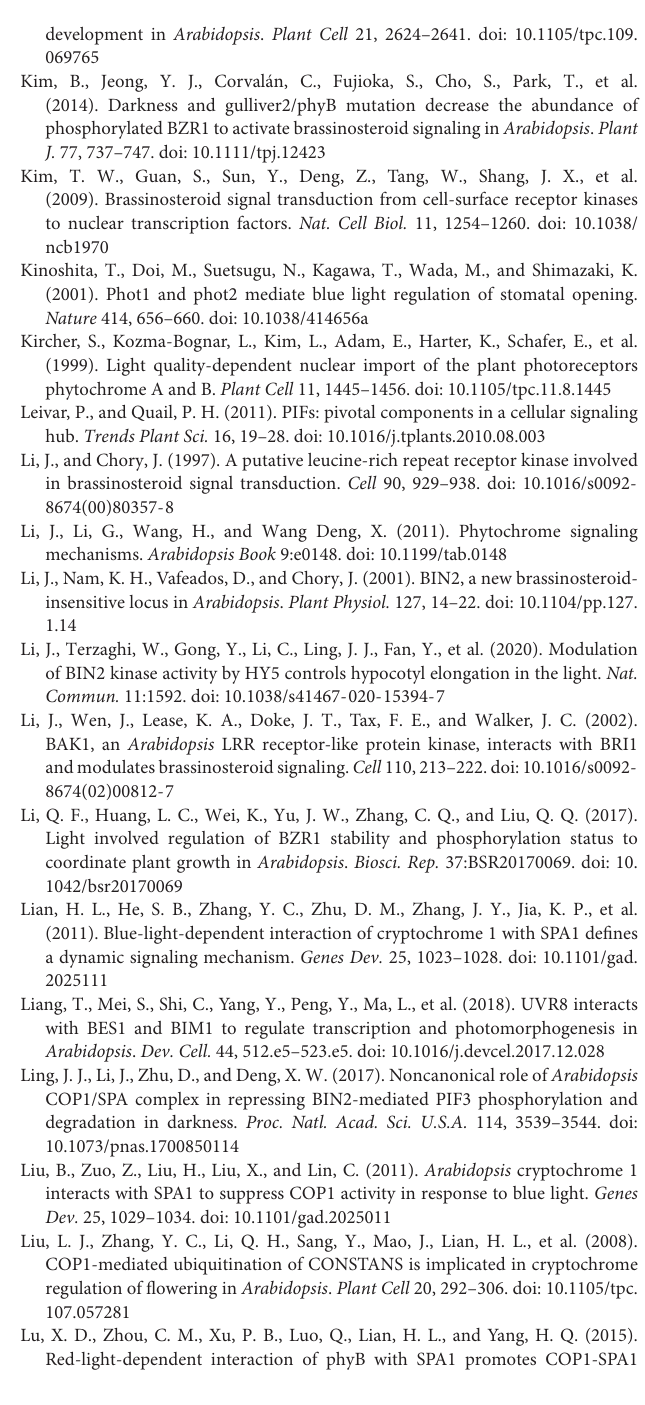
Supplementary Figure 4 | The original images of immunoblots used in this paper to prepare figures. Supplementary Figure 5 | The original images of immunoblots used in this paper to prepare figures. Supplementary Table 1 | The primers used in this